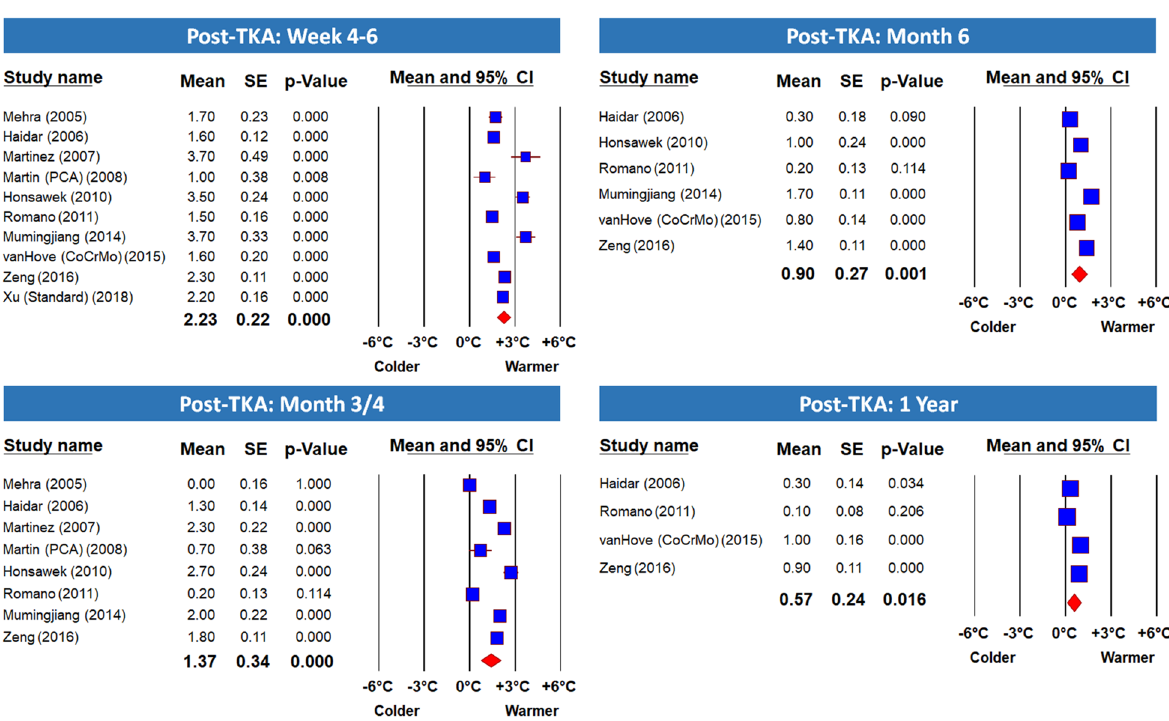
Figure 3. Meta-Analysis Forest Plots of ΔST Before TKA and at Early Follow Ups. This panel presents Forest plots of the mean temperature differences between the operated and non-operated knees (ΔST) before and up to 2 weeks post TKA using the random-effect model. Articles in each Forest plot are listed by year of publication. The mean, standard error and p -value of each study, and the pooled mean difference, are presented. Note that the difference in temperature between knees is significantly greater at all time points—even before the surgery.